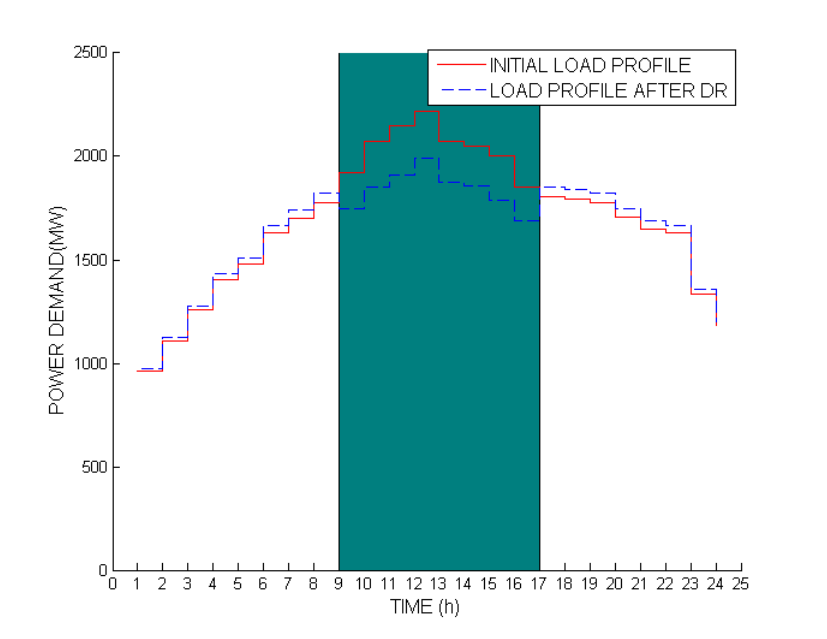
Figure 10. Initial load profile and final load profile after DR for Case